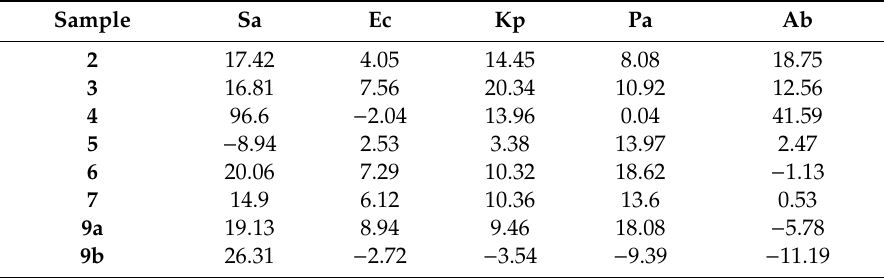
Table 2. Inhibition of bacterial growth,